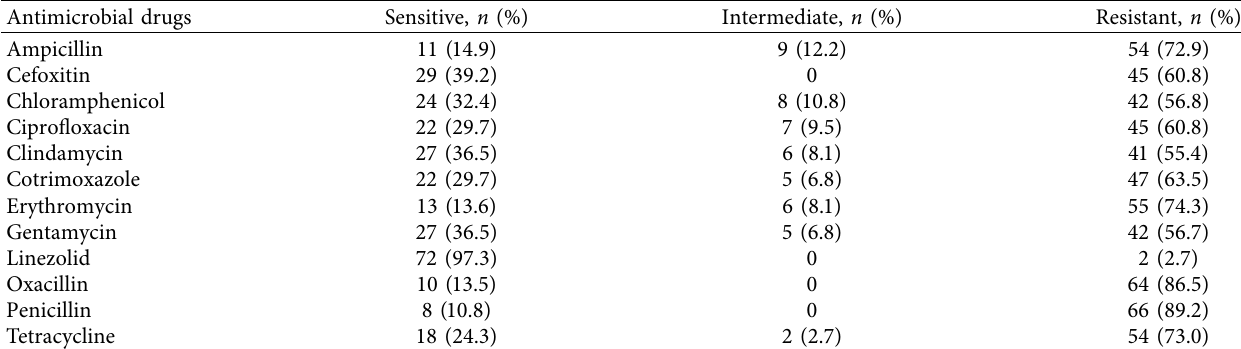
Table 2: Antimicrobial susceptibility patterns of S. aureus isolates ( n � 74). Antimicrobial drugs